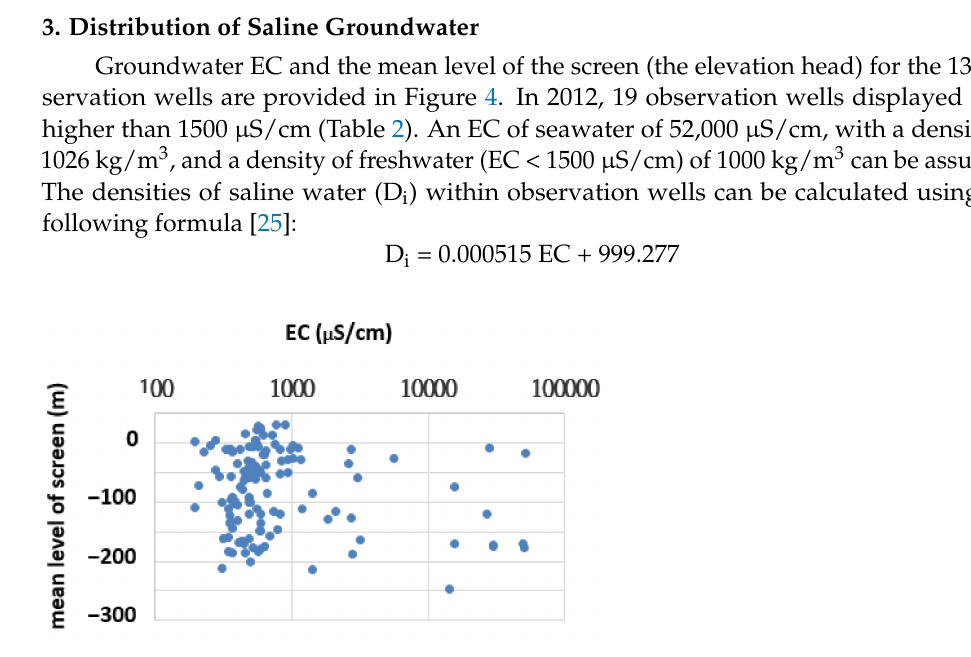
Figure 4. Groundwater EC and the mean level of the screen (elevation head) for the 134 total observation wells within the Pingtung Plain (2012 data from [21]). Table 2. The freshwater heads of observation wells with EC >1500 µ S/cm during